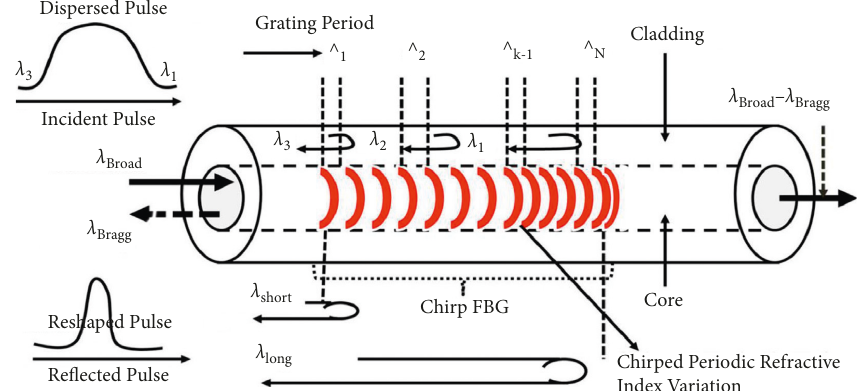
Figure 1: Nonuniform fiber Bragg gratings